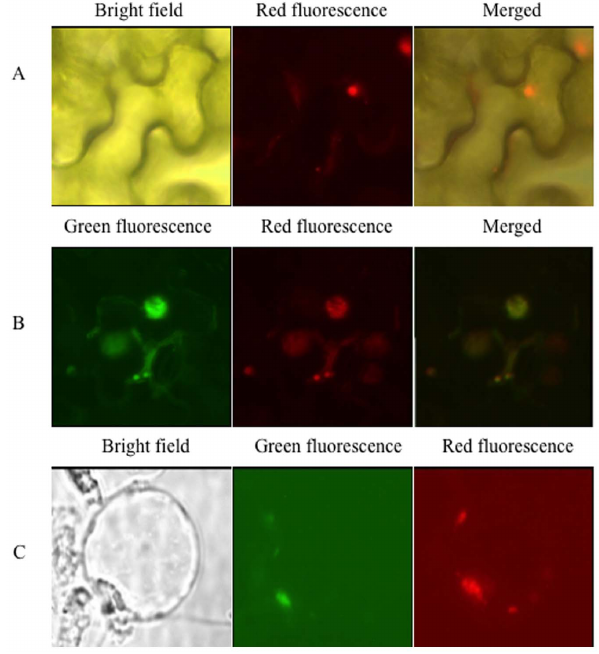
Figure 2. Subcellular localization of RBS1 in N.benthamiana and rice. (A) DsRed-RBS1 localization in the nucleus of N. benthamiana (B) GFP-SPIN1 and DsRed-RBS1 co-localization in the nucleus of N. benthamiana (C) GFP-SPIN1 and DsRed-RBS1 co-localization in the nucleus of rice protoplasts.